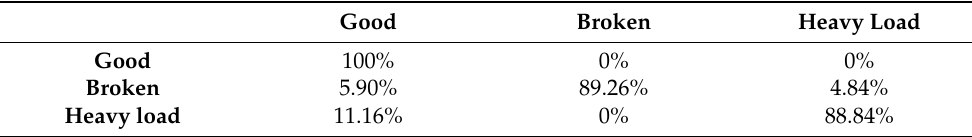
Table 9. Confusion matrix of the STM model.